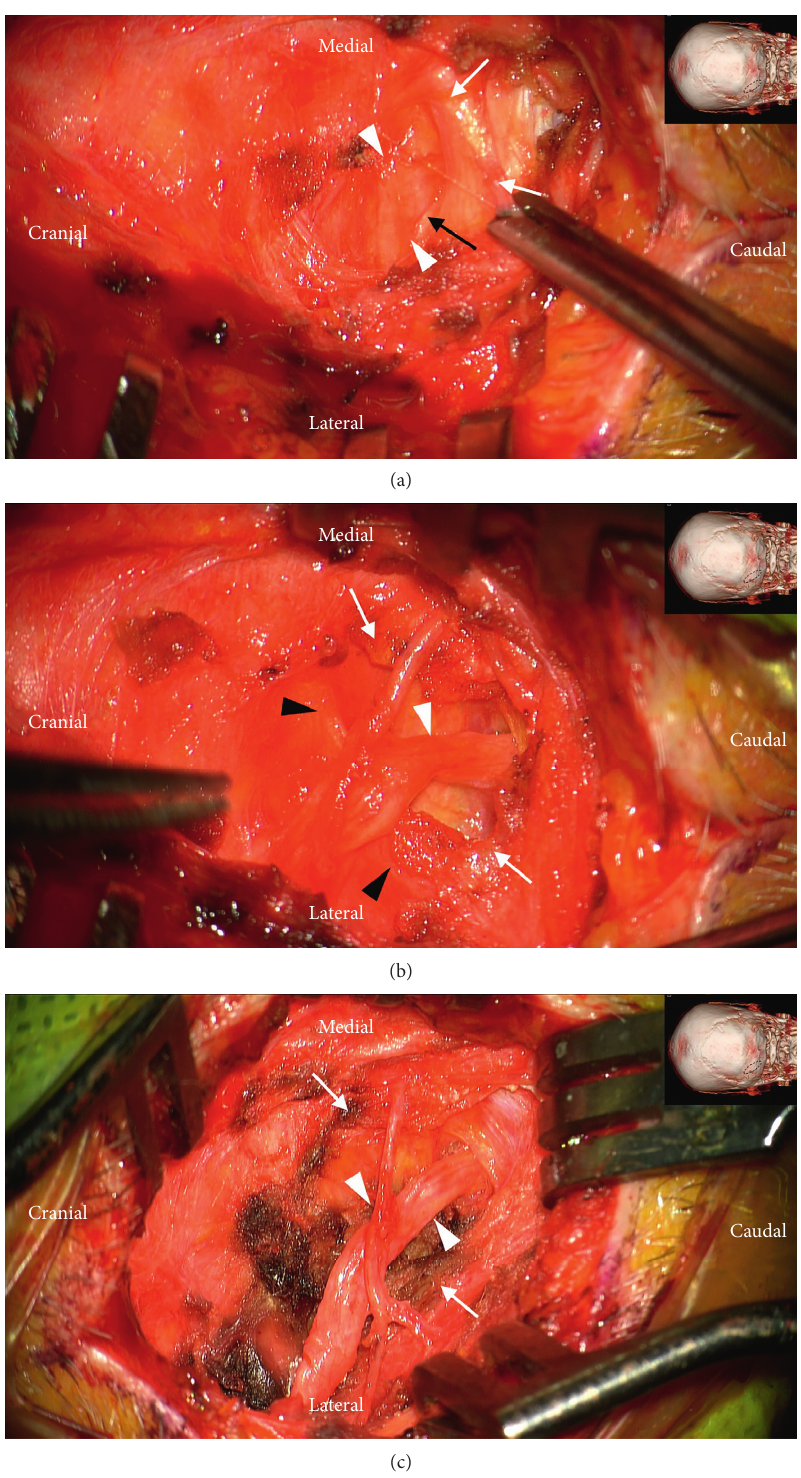
Figure 2: Intraoperative photographs during the decompression of the greater occipital nerve (GON). (a) Intraoperative photograph showing severe entrapment of the GON (white arrowheads) by the aponeurotic fibrous attachment of the trapezius (white arrows) at the superior nuchal line. The maximal compression point (black arrow) is seen by lifting the trapezial aponeurotic edge. The inset shows the direction of the photo and the location of the incision. (b) Intraoperative photograph after decompression of the left GON (white arrow heads) with the division of the trapezial aponeurosis (white arrows). Even after decompressing the upper side, the GON was still depressed by the lower fascial aponeurosis (black arrowheads). (c) Intraoperative photograph after complete decompression of the left GON (white arrowheads). Its proximal and distal courses are